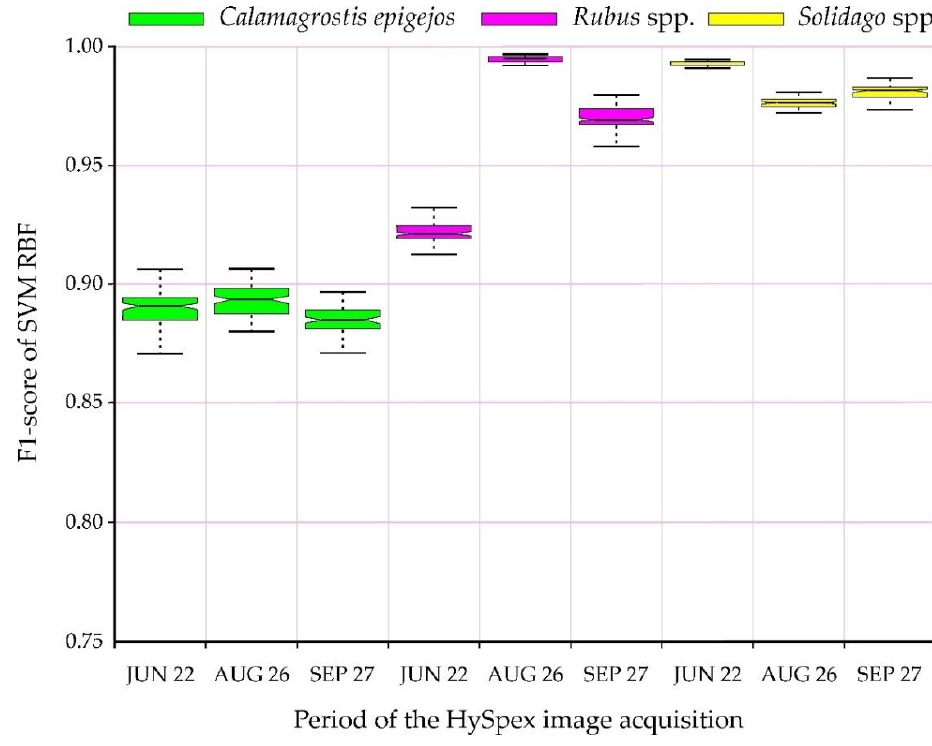
Figure 5. F1-score distribution for analyzed plant species.